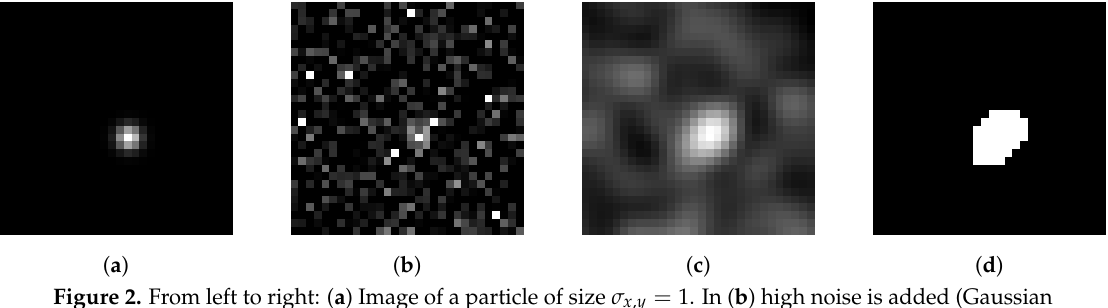
Figure 2. From left to right: ( a ) Image of a particle of size σ x , y = 1. In ( b ) high noise is added (Gaussian noise with SNR = 5, and salt and pepper noise with a probability of 0.5 %), ( c ) the noisy image is then filtered by a Hanning amplitude filter with N = 5, ( d ) and finally the filtered image is clustered by Otsu’s